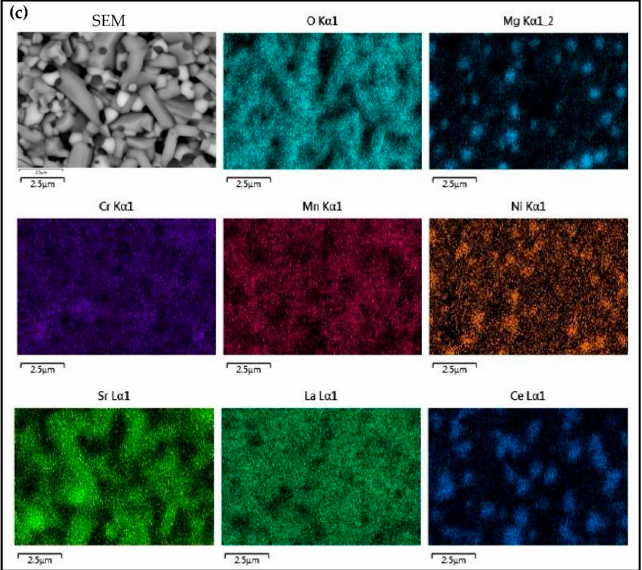
Figure 10. EDS analysis of HEO 4 and HEO 5. ( a ) elementary cartography of HEO 4 after annealing at 1400 ◦ C and ( b ) after cycling. ( c ) Elementary cartography of HEO 5 after annealing at 1400 ◦